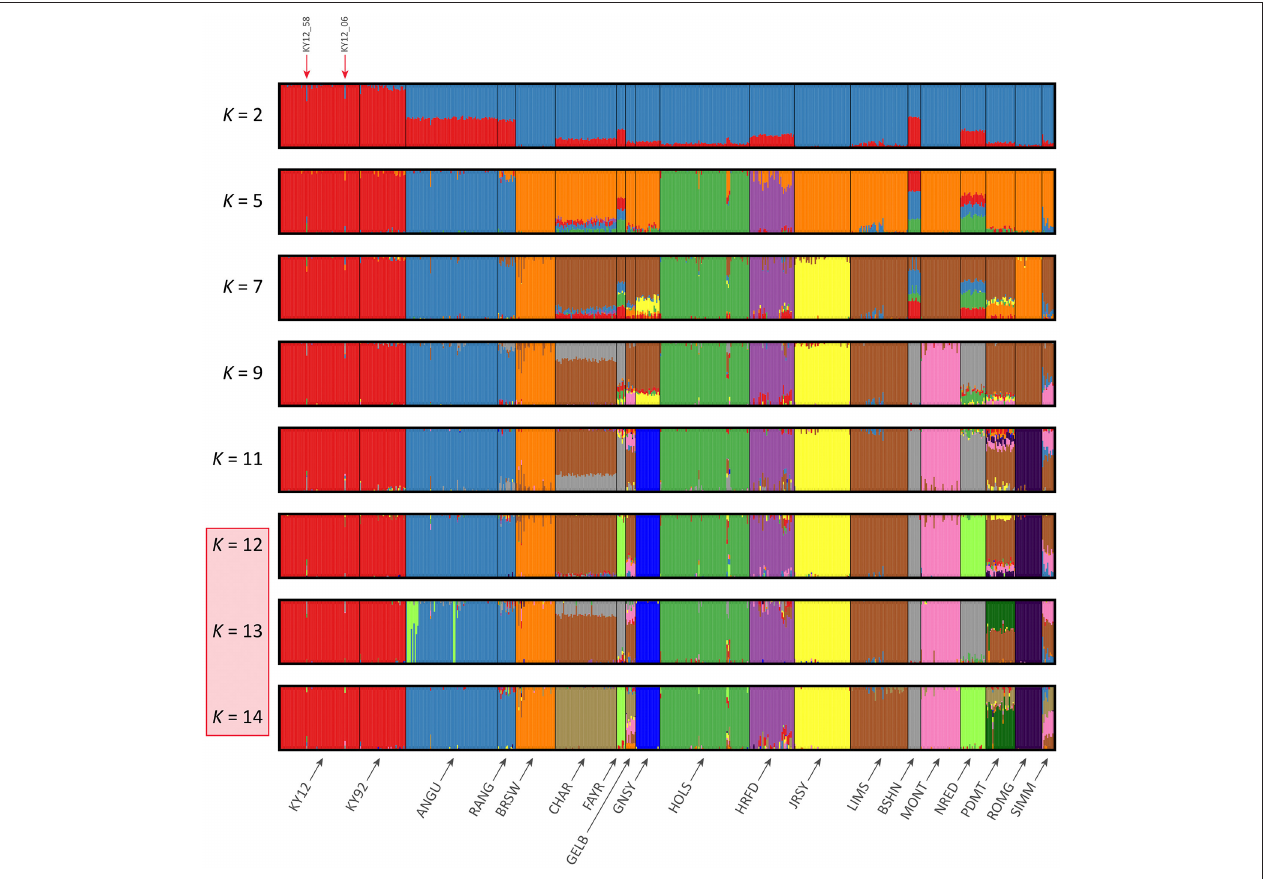
FIGURE 6 | Hierarchical clustering of individual animals using genome-wide SNP data (36,621 autosomal SNPs) for the EU data set of 605 individual animals. Results are shown for modelled ancestral populations K = 2–14. The cluster numbers corresponding to the likely number of ancestral populations are highlighted with a light red overlay and the two outlier Kerry samples (KY12_06 and KY12_58) are indicated with red